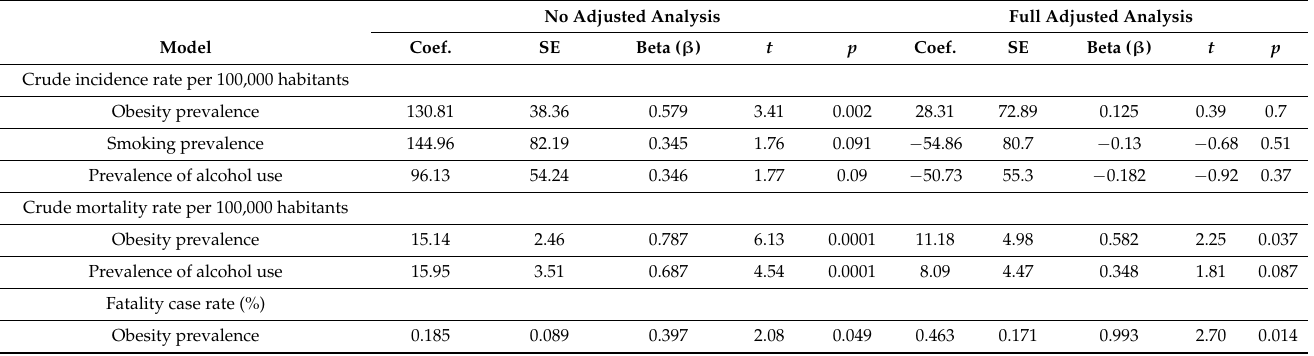
Table 3. Multiple regression analysis of the prevalence rates of obesity, smoking, and alcohol use with the incidence, mortality, and case fatality rates due to COVID-19 in 2020 *. No Adjusted Analysis Full Adjusted